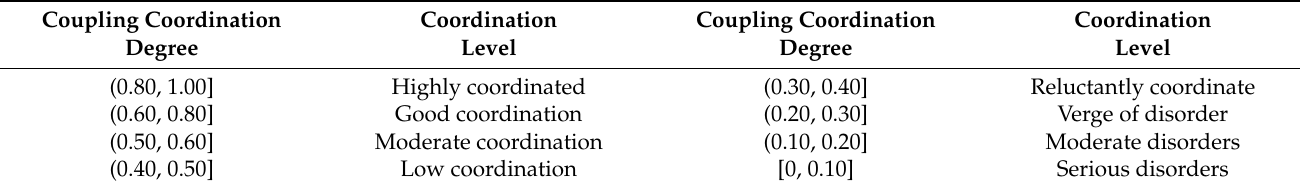
Table 3. Classification of coupling coordination